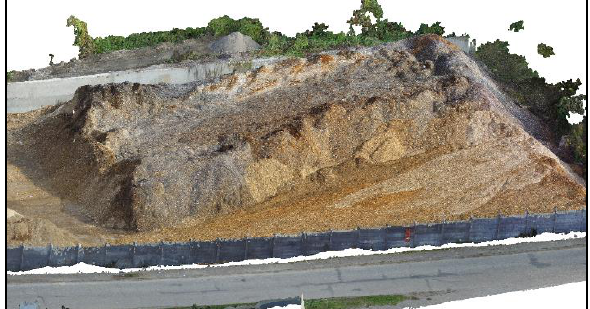
Figure 5. Dense point cloud of wood chips pile (Hnúšťa)